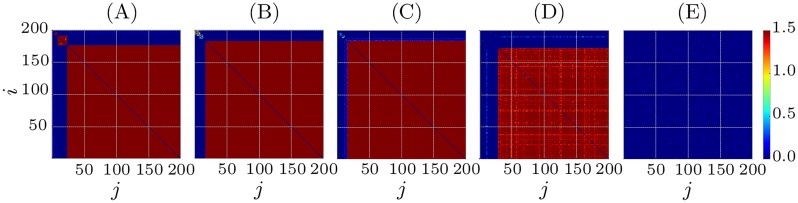
Influence of independent random input on clusters.Coupling matrices for t = 10000ms and different amplitudes of independent random input I (see Eq (4)). (A) I = 0.005, (B) I = 0.01, (C) I = 0.02, (D) I = 0.05 and (E) I = 0.07. All other parameters as in Fig 5.